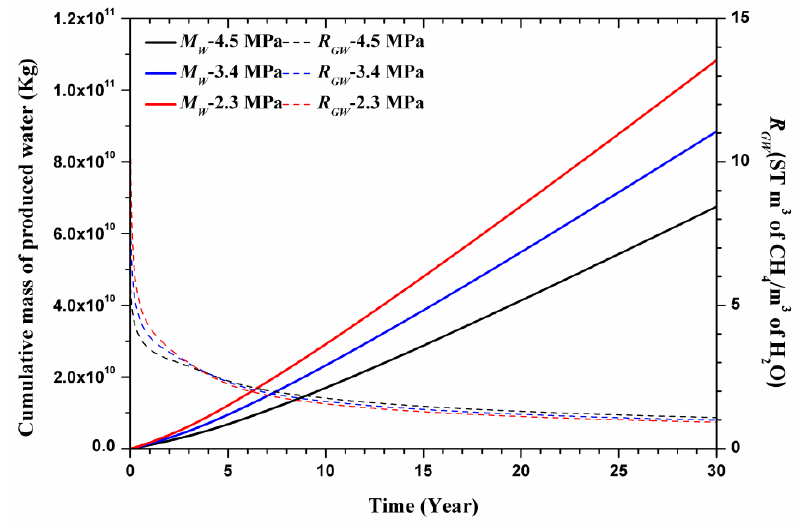
Figure 13. Sensitivity to the production pressure ( P W ): evolution of M W and R GW overtime.